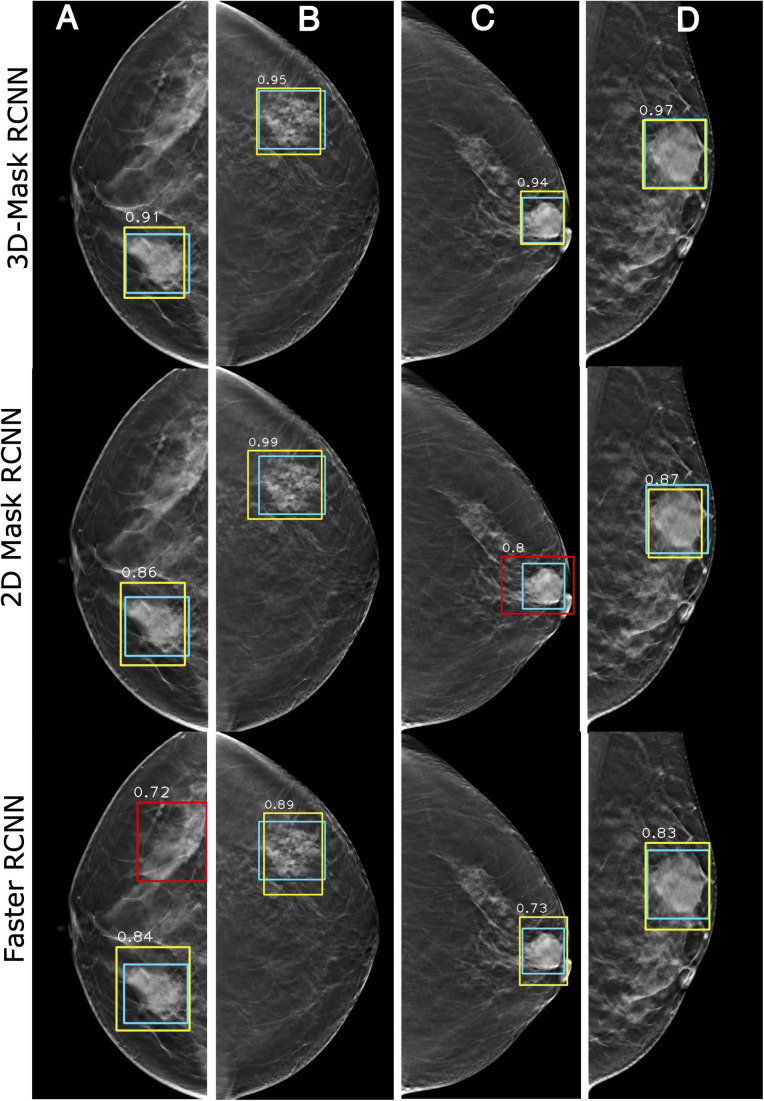
Examples of mass detection results using the 3D-Mask RCNN, 2D-Mask RCNN and Faster RCNN on patients with different densities. Four patients are included (from left to right) with the following characteristics: (A) aged 55 years, low density breast, malignant tumor, spiculate mass, and maximum tumor diameter of 43.24 mm; (B) aged 54 years, low density breast, malignant tumor, irregular mass, and maximum tumor diameter of 28.36 mm; (C) aged 69 years, low density breast, malignant tumor, oval mass, and maximum tumor diameter of 28.36 mm; and (D) aged 45 years, dense breast, malignant tumor, oval mass, and maximum diameter of 41.42 mm (green: ground truth box, yellow and red: detection box).